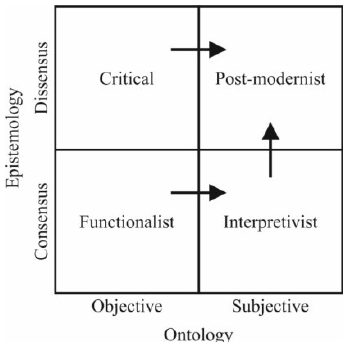
Figure 1. Transition zones between crowdsourcing paradigms (source: created by